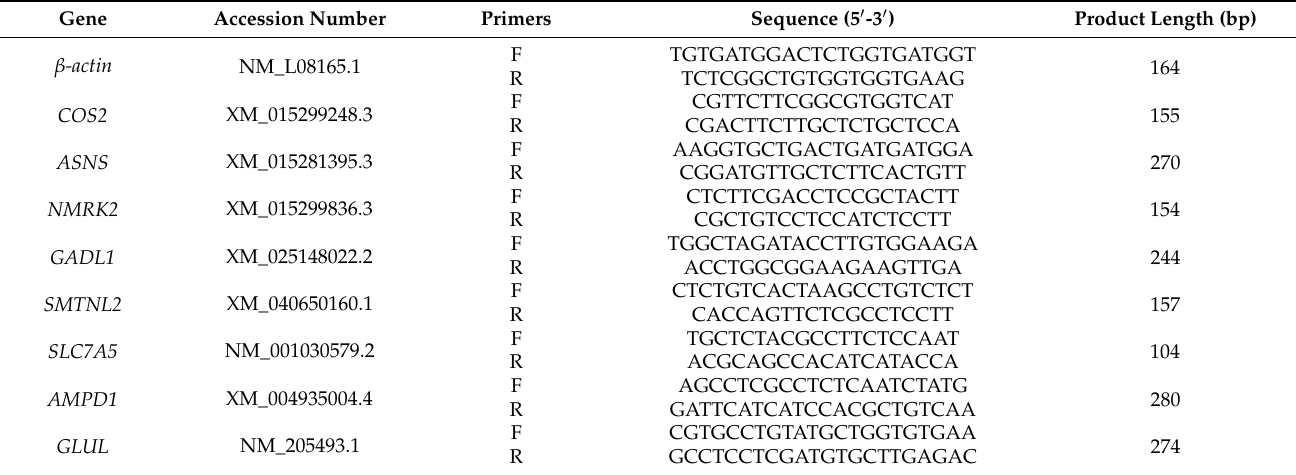
Table 1. Primer pairs used for real-time PCR of Lueyang black-bone chickens in this